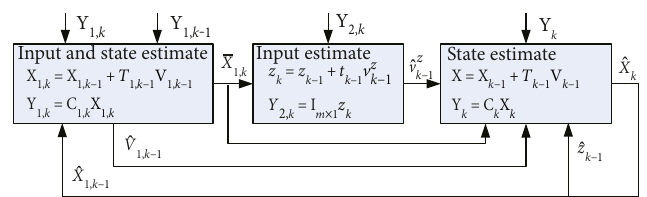
Figure 2: Block diagram of three-step SISE algorithm for multi-USV positioning